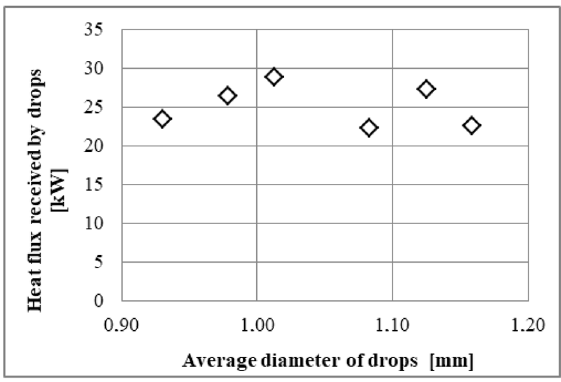
anglesFigure 6. Heat received by drops vs average diameter of